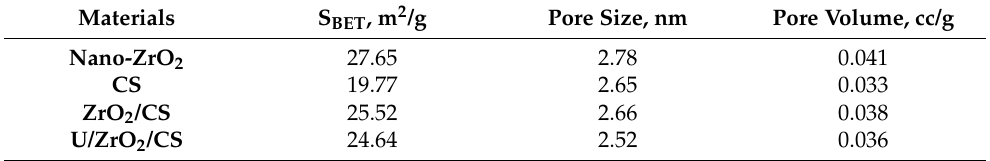
Table 1. Specific surface area, pore size, and pore volume nano-ZrO 2 , CS, ZrO 2 /CS, and U/ZrO 2 /CS.